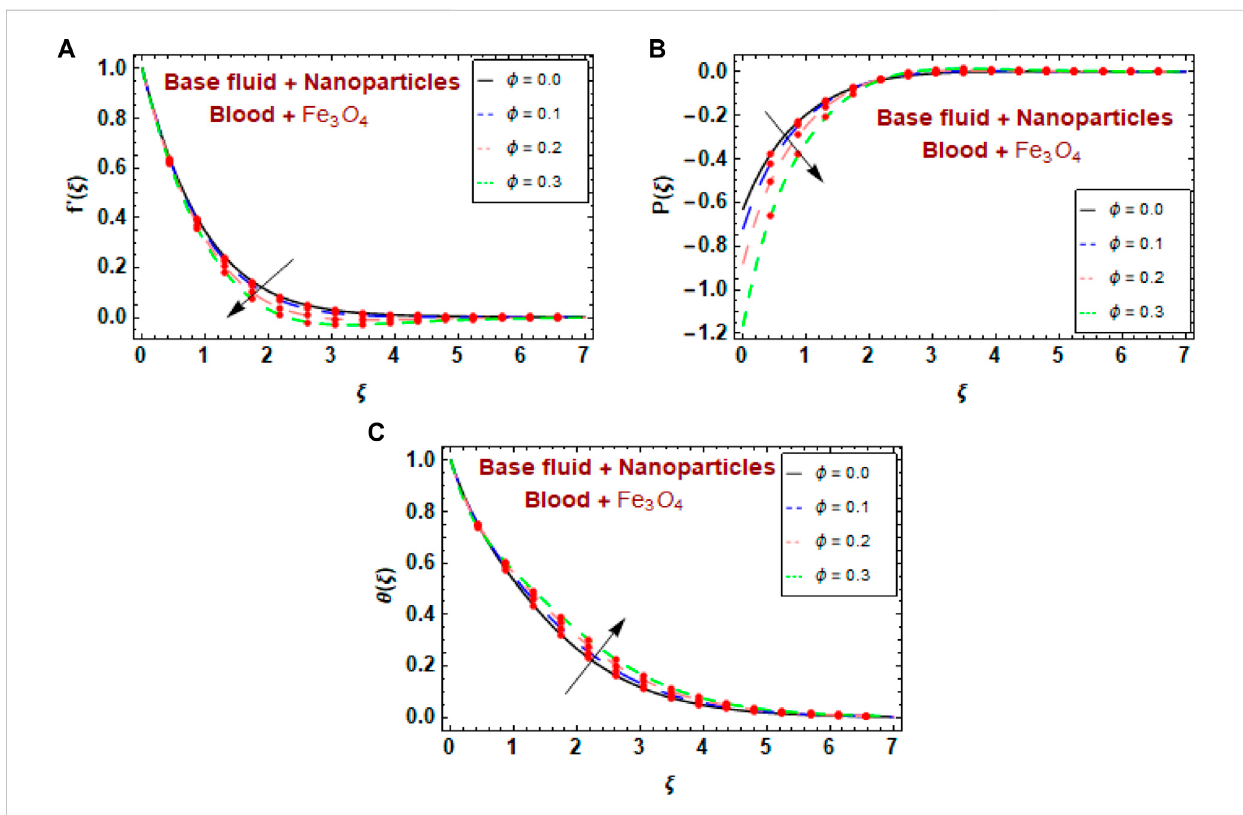
FIGURE 6 (A – C) Variations in f ′ ( ξ ) , p ( ξ ) , and θ ( ξ ) for distinct numbers of ϕ .